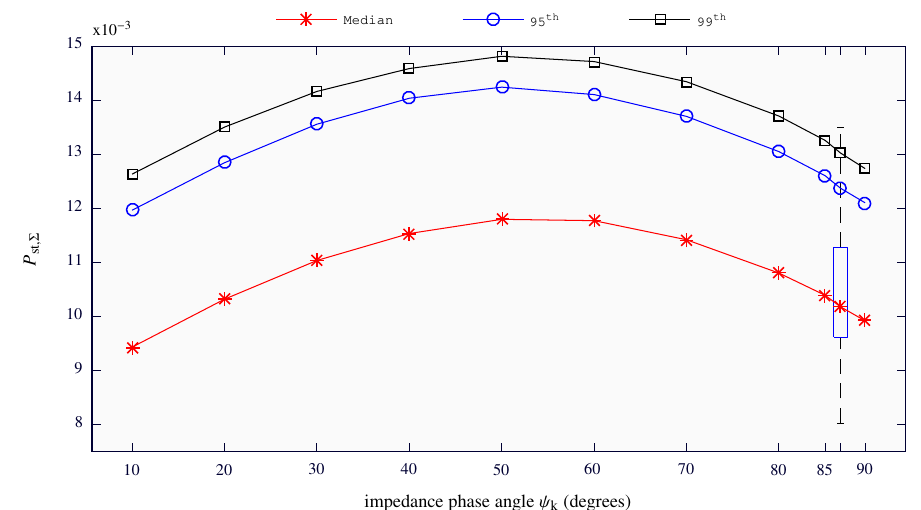
Figure 5. Statistics of the estimated P st, Σ values at the PCC with respect to the ψ k values: median (red asterisks), 95th percentile (blue circles) and 99th percentile (black squares). A boxplot is depicted to represent the distribution for the particular case of ψ k = 87.34 ◦ .